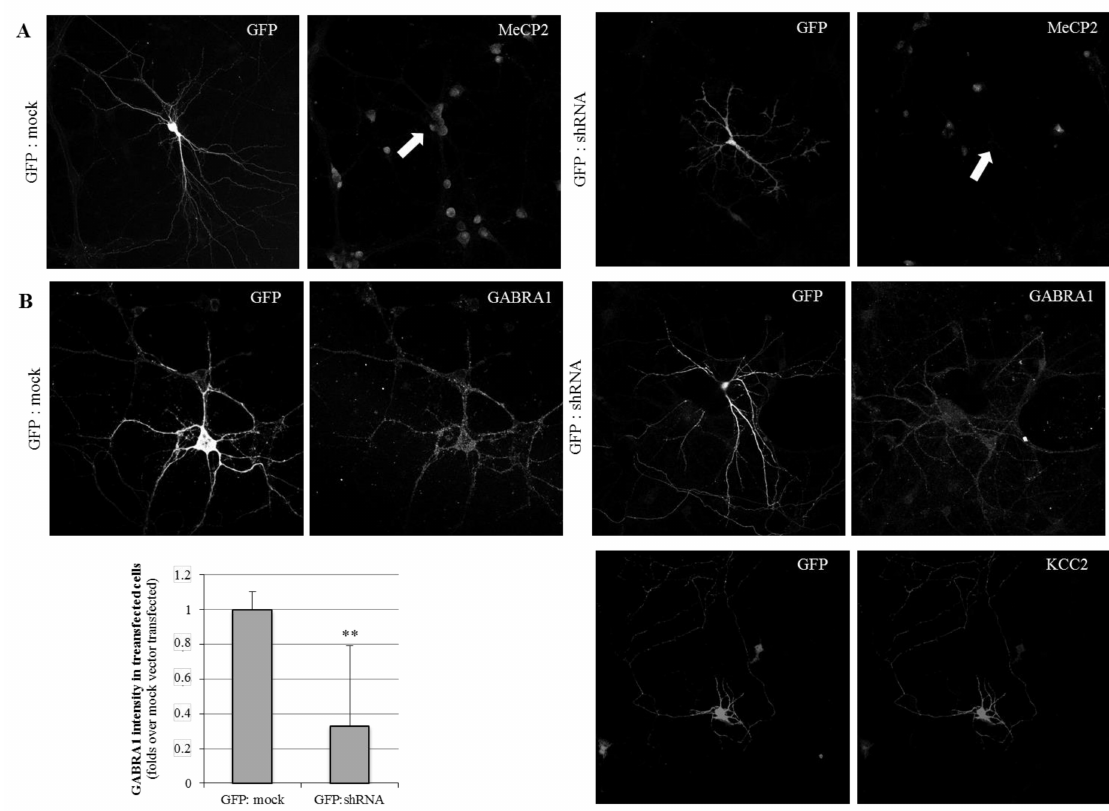
Figure 2. Immunofluorescence analysis of MeCP2, GABRA1, and KCC2 expression in cortical primary neuronal cultures. Cells were transfected with either GFP and mock DNA, or GFP and shRNA-anti-(3 (cid:48) UTR)Mecp2. Images show neurons at DIV11. Images were taken at 63x with constant time of exposure. Transfected neurons were labeled with anti-GFP and anti-Mecp2 ( A ). For the GABRA1 and KCC2 immunostaining ( B ), di ff erent neurons are shown. The quantification of the mean GABRA1 immunosignal in mock and shRNA transfection conditions is shown in the bar graph. n = 10 di ff erent neurons, from two independent cultures. ** refer to p -value <